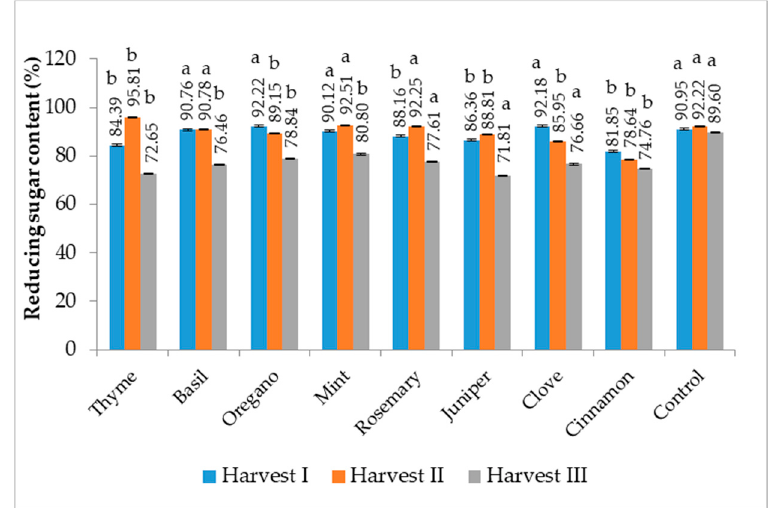
Figure 7. The reducing sugar content of the samples before (Harvest I), after (Harvest II) the use of EOs in the supplementary food of bee families, respectively after the first harvest (rapeseed) (Har- vest III). Different letters between control and samples indicate significant differences ( p < 0.05) among these values according to the t -test. these values according to the t -test.